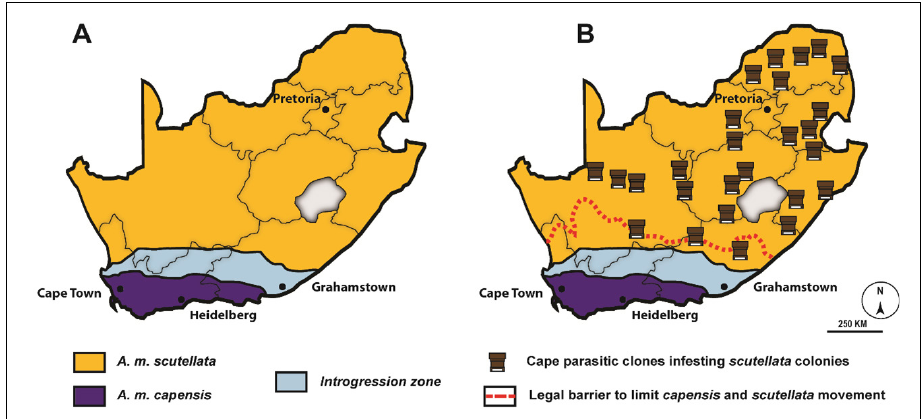
Map of South Africa showing the distribution of the two subspecies of honey bee – Apis mellifera scutellata (yellow) and A. m. capensis (purple) – (A) prior to 1990 and (B) after the anthropogenic establishment of parasitic laying workers (brown hives) after 1990. The red dotted line shows the legal barrier (Reg. 159/ 5 February 1993) enacted to restrict the movement of colonies of A. m. capensis and A. m. scutellata beyond the stable zone of introgression (light